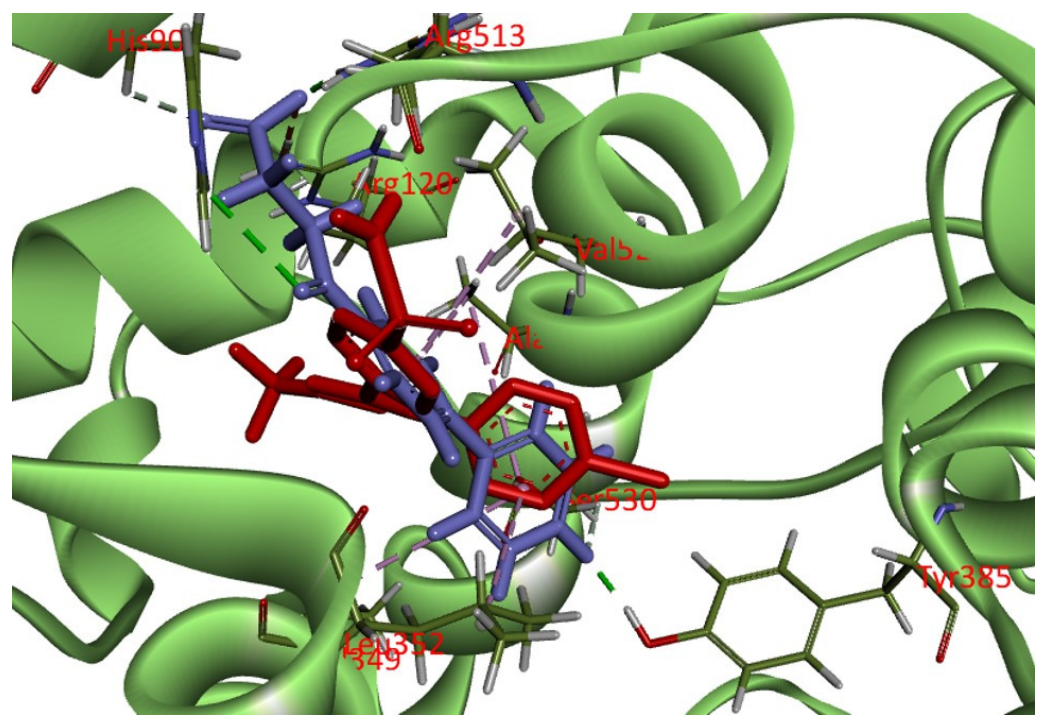
Figure 10. Overlaying of the most potent p-hydroxy fenbufen 6l with the original bromocelecoxib (SC58). 6l was specified in purple and bromocelecoxib was marked in blood red.